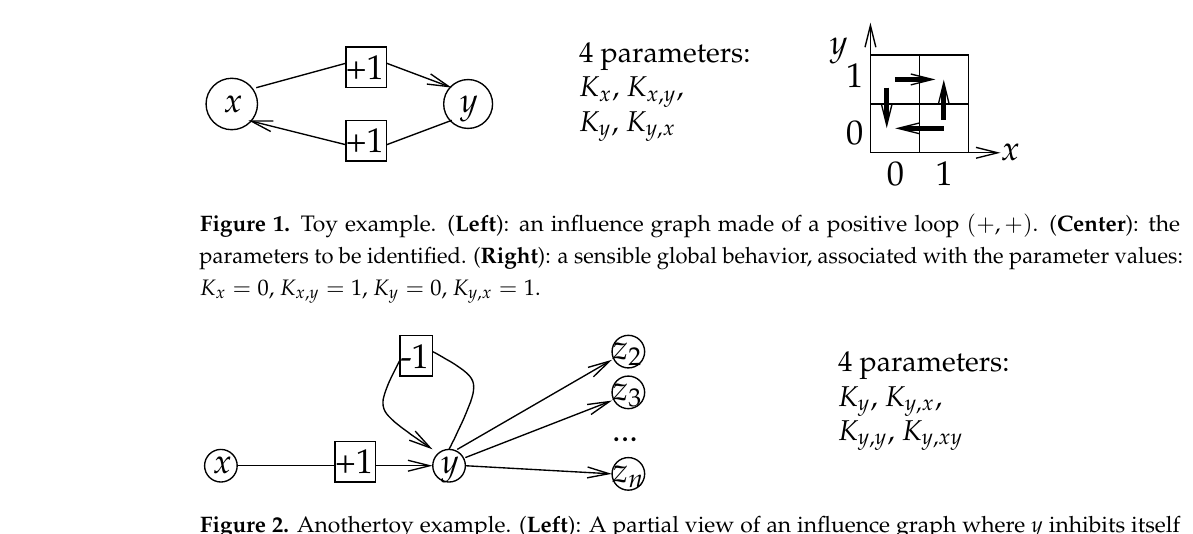
and is activated by x . ( Right ): the four parameters to be identified. activated by x . Right: the four parameters to be identified.